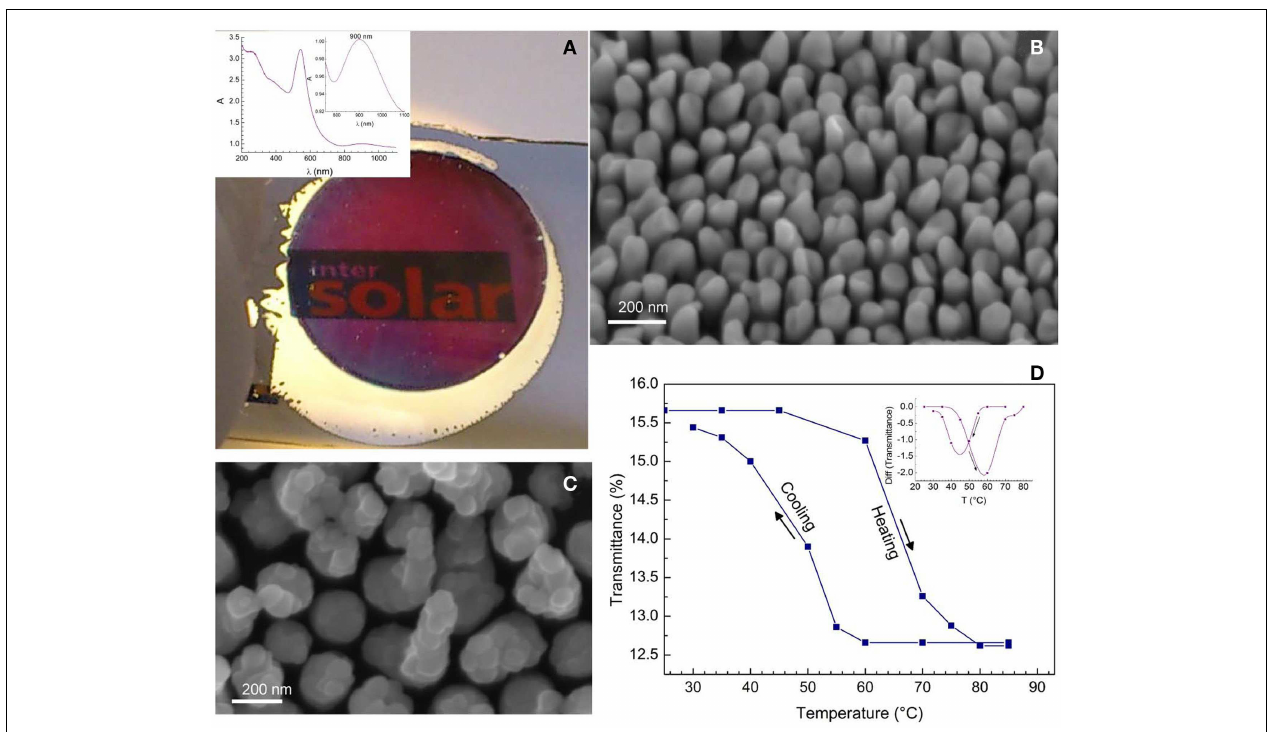
Au-NRs. (C) Composite structure ofVO 2 on Au-NRs. (D) Hysteresis loop on heating and cooling showing the insulator to metal transition ofVO 2 ; the inset shows the transition temperature (Habouti and Es-Souni,